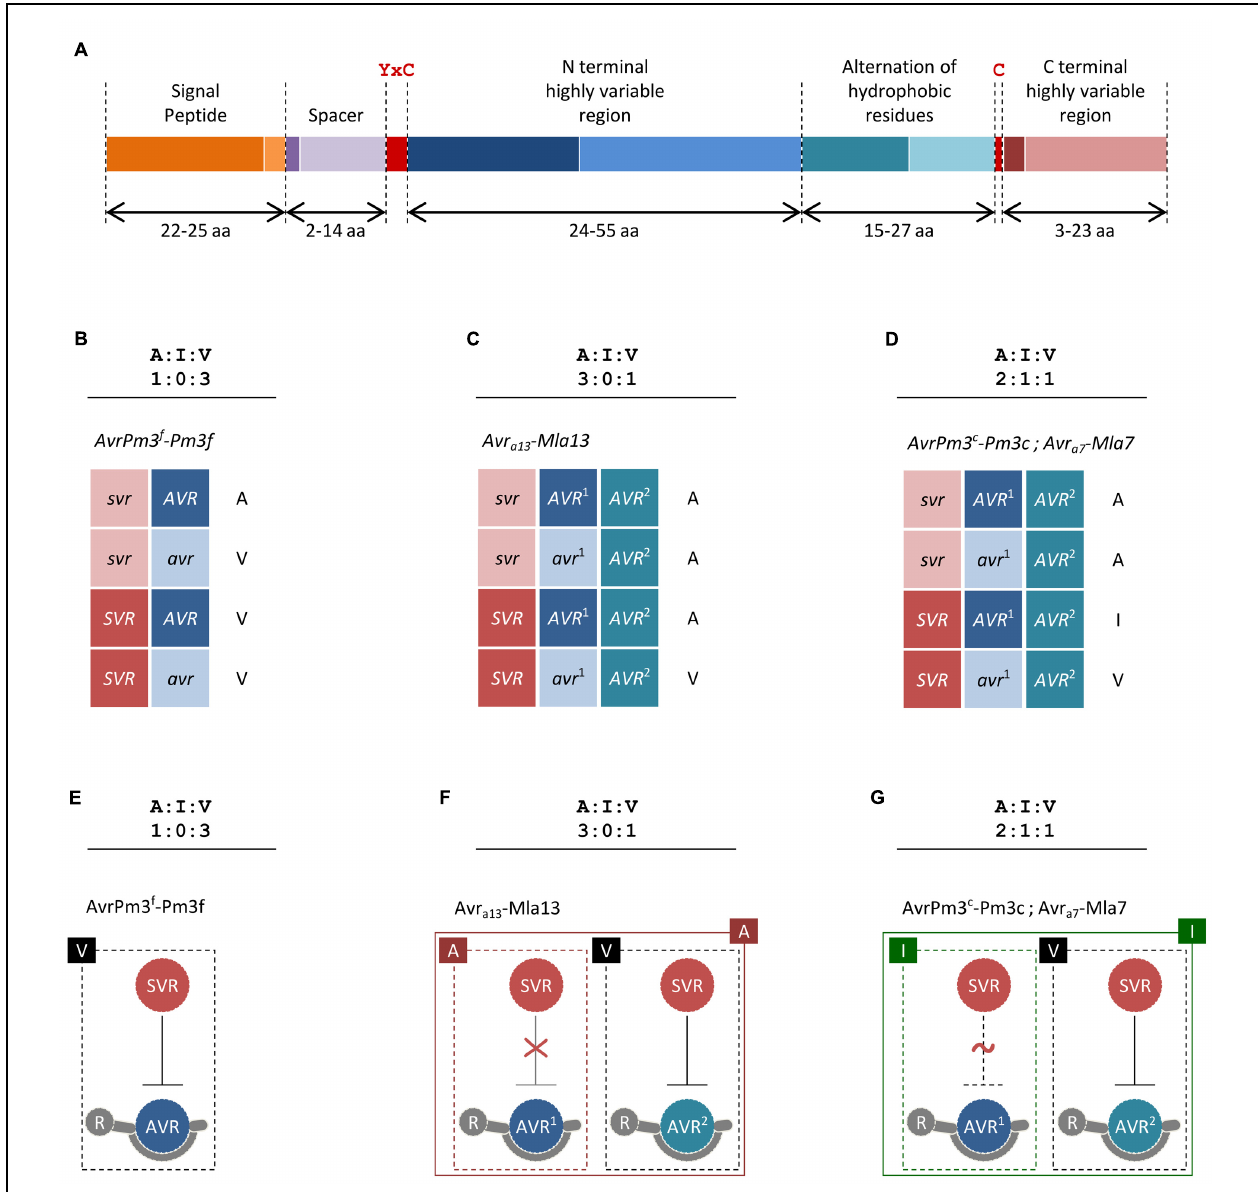
FIGURE 1 | Proposed models for Avr – R – Svr interactions in cereal powdery mildews. (A) Structure of the AvrPm3 a 2 / f 2 effector family. Minimum and maximum sizes of each region as observed among family members are given in amino acids (aa) and differentiated with dark and light color shades, respectively. The YxC motif and the conserved cysteines are indicated in red. (B–D) Proposed Avr-R-Svr genetic models for the interpretation of genetic segregation ratios deviating from the canonical 1:1 single gene hypothesis. For readability, active and inactive alleles are distinguished with upper and lower case. Here, we have only considered examples of mildew Avr–R interactions where genetic segregation ratios and mapping data were consistent with at least two genetically independent loci being involved in avirulence. (B) Considering the Avr-R-Svr model and a genetic segregation ratio of 1:0:3, avirulence results from a combination of an inactive suppressor allele ( svr ) and an active avirulence allele ( AVR ). In the presence of the active SVR and the active AVR , the interaction result in virulence. A molecular model for this suppression scenario is depicted in (E) . (C) Considering the Avr-R-Svr model, a genetic segregation ratio of 3:0:1 can be explained by a model involving one suppressor locus and two loci for avirulence ( AVR 1 and AVR 2 ). Importantly, the second locus for avirulence ( AVR 2 ) is not polymorphic in this cross, thus only the active allele ( AVR 2 ) is present. In this model, the active SVR is only effective in suppressing AVR 2 but not AVR 1 . A molecular model for this suppression scenario is depicted in (F) . (D) Considering the Avr-R-Svr model, a genetic segregation ratio of 2:1:1 can be explained by a model involving one suppressor locus and two loci for avirulence ( AVR 1 and AVR 2 ). Importantly, the second locus for avirulence ( AVR 2 ) is not polymorphic in this cross, thus only the active allele ( AVR 2 ) is present. In this model, the active SVR can fully suppress AVR 2 but is only partially effective on AVR 1 , thus resulting in avirulence in the first case and intermediate virulence in the second. A molecular model for this suppression scenario is depicted in (G) . (E–G) Proposed suppression scenarios based on the genetic models described in (B–D) and resulting in three major phenotypic classes of avirulence ‘A,’ virulence ‘V,’ and intermediate virulence ‘I.’ Only active suppressor and avirulence proteins are shown. For simplicity, AVR–R interactions are represented as physical binding. Absence of suppression is depicted as a red “X” sign. Partial suppression is depicted as a dotted line and a red “ ∼ ” sign. The phenotype resulting from single and combined interactions is indicated.